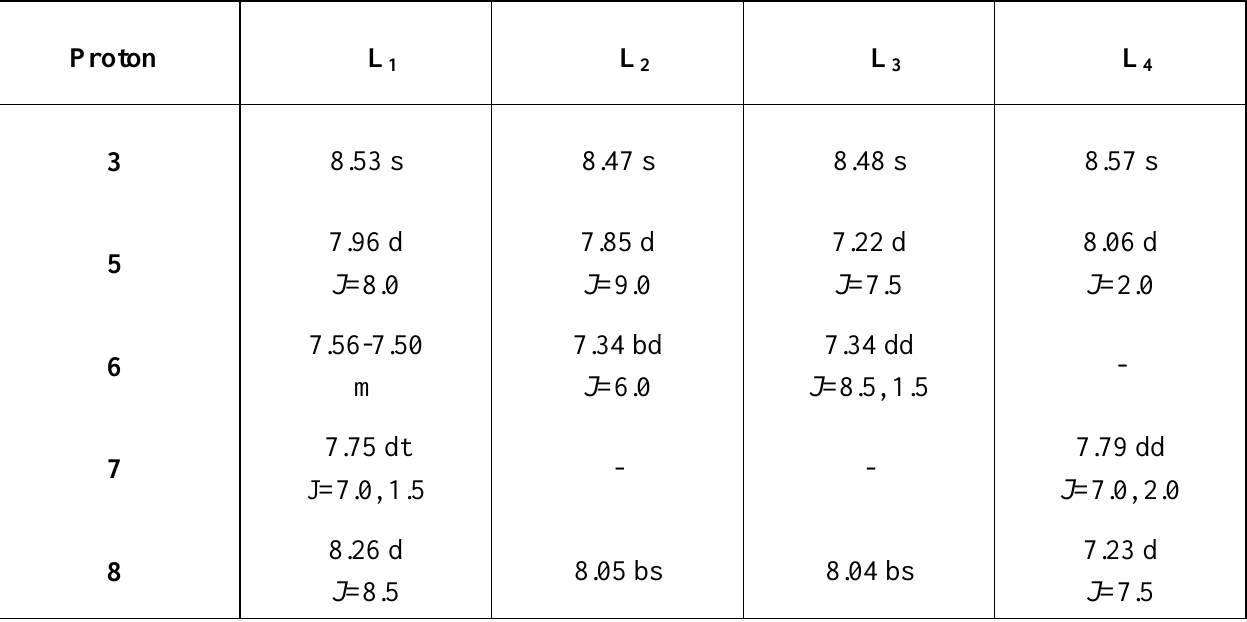
Table I. 1 H NMR parameters of ligands L